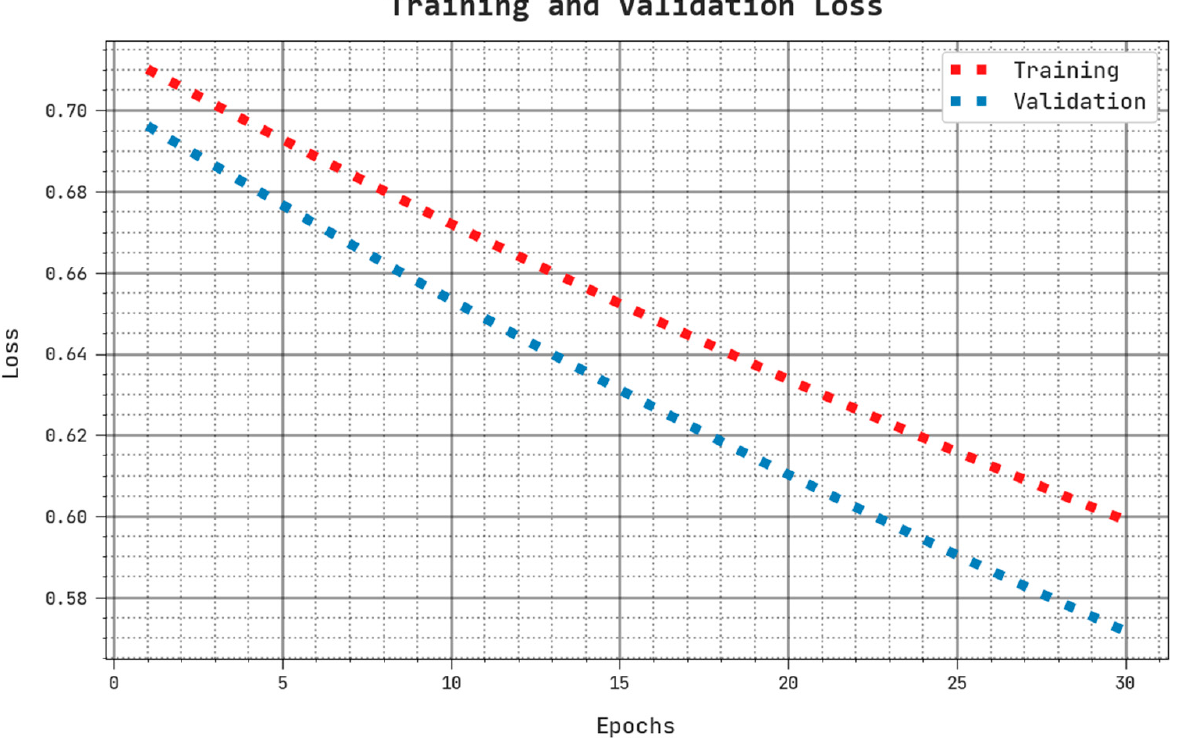
Figure 9. TLS and VLS analysis of AHBATL-MNC approach.